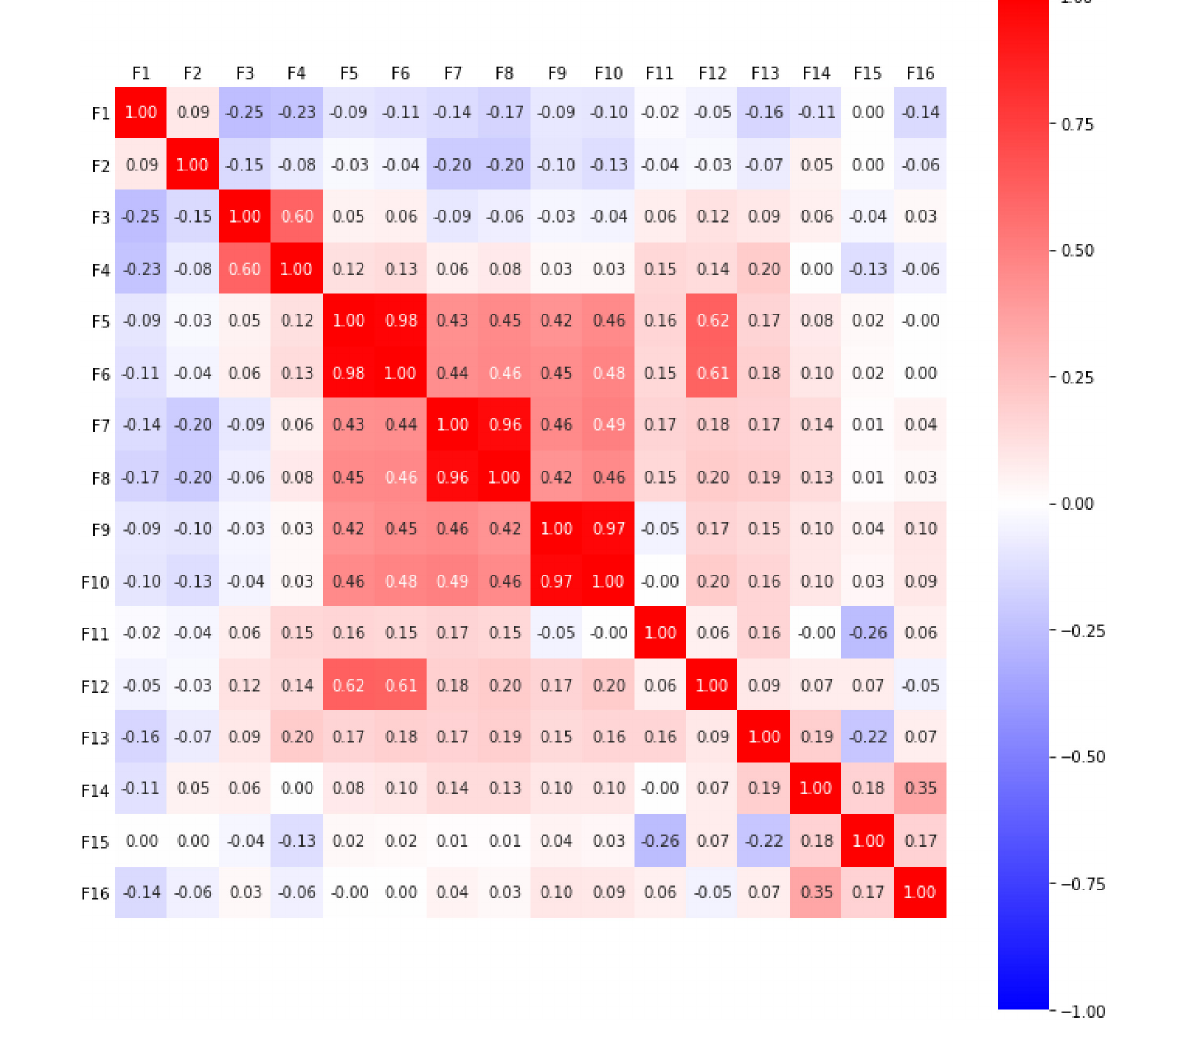
FIGURE1 Spearman’s rank correlation coefficients for all features.